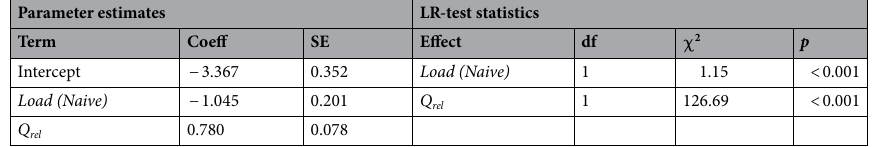
Table 3. Logit-parameter estimates and corresponding likelihood-ratio test statistics for the best supported GLM fitted to predict fish passage probabilities for fish passage experienced and fish passage naive PIT-tagged